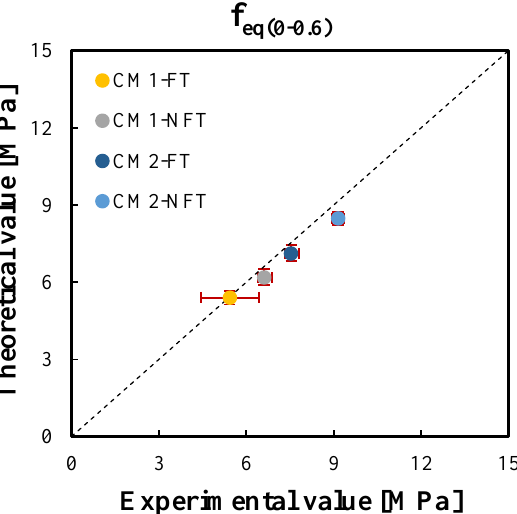
Figure 11. Correlation between the experimental and theoretical average values of the equivalent postcracking strengths after the freeze – thaw cycles, 𝑓 𝑒𝑞(0–0.6),𝑎𝑣𝑔𝐹𝑇 and before the freeze – thaw cycles of Ref. [42], 𝑓 𝑒𝑞(0–0.6),𝑎𝑣𝑔 𝑁𝐹𝑇 for the CM1 and CM2 mixtures.